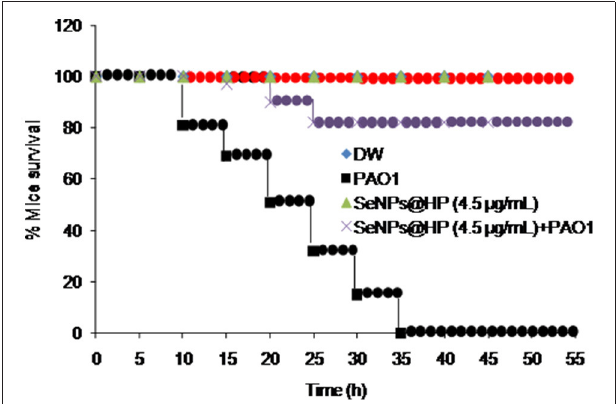
FIGURE 6 | Determination of in-vivo anti-QS activity of SeNPs@HP using mice mortality assay. Cell suspension (2.0 × 10 7 cfu/mL) was prepared from overnight grown culture of P. aeruginosa and injected into the abdominal cavity of 4 weeks old pathogen free female mice. Mortality was measured during a 45h period for 12 mice for each treatment. DW and SeNPs@HP in DW was injected into mice as negative controls.